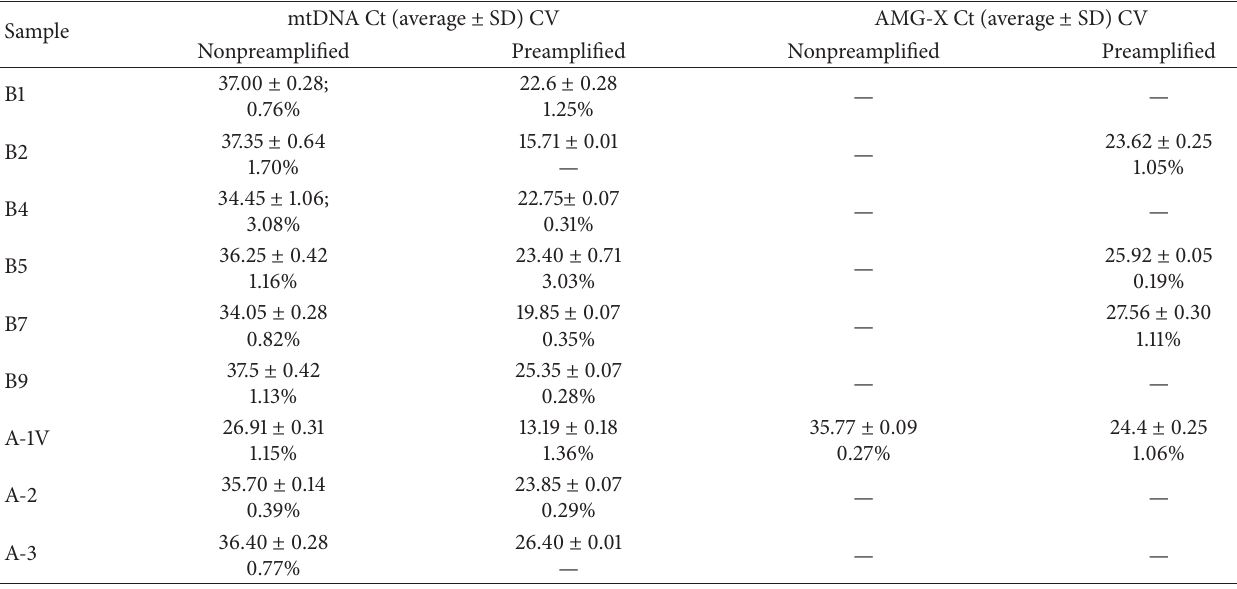
Table 3: qPCR analysis of nonpreamplified and preamplified samples. Ct averages, standard deviations (SD), and coefficients of variation (CV) of mtDNA and AMG-X targets from nonpreamplified and preamplified aDNA